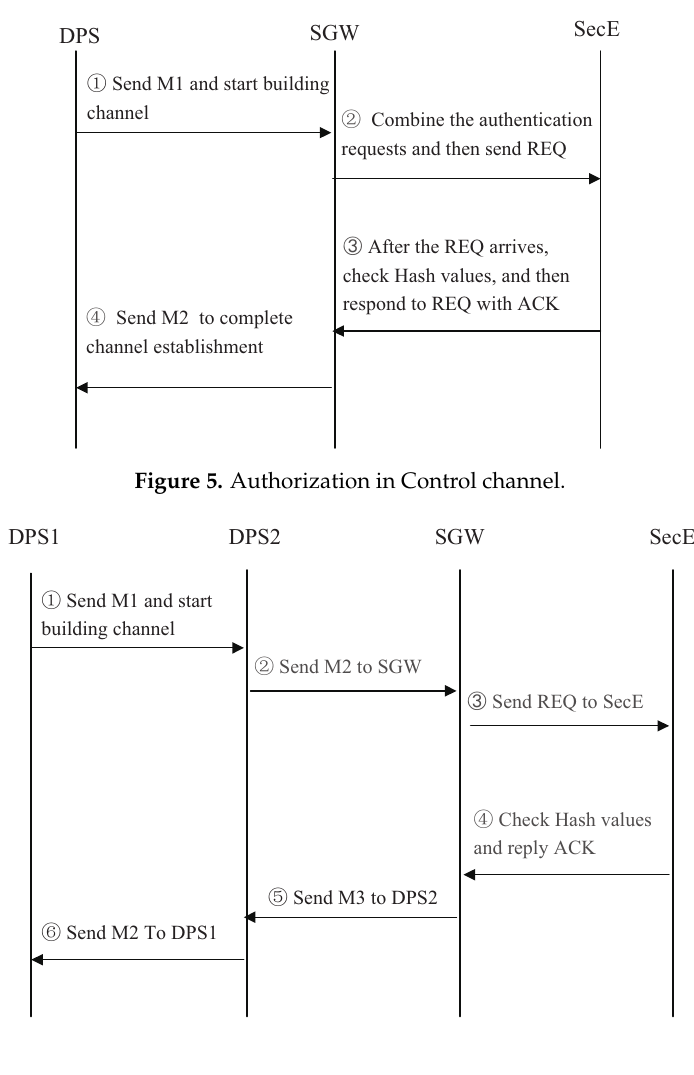
Figure 6. Authorization in Data